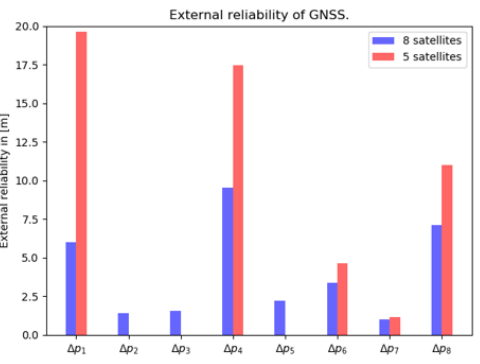
Figure 11. External reliability computed by 8 satellites (in blue) and 5 selected satellites (in red) in [m], presented in the local reference